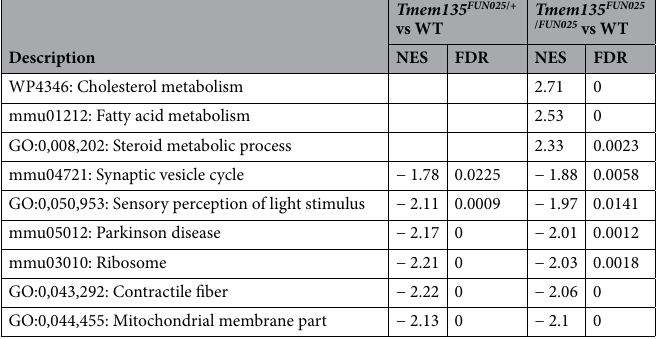
Table 1. Pathway analysis using Gene Set Enrichment Analysis on Tmem135 FUN025 /+ and Tmem135 FUN025 / FUN025 compared to WT gene sets*. *FDR cut-off of 0.01 is used for analysis. Empty cells indicate FDR was greater than 0.01.